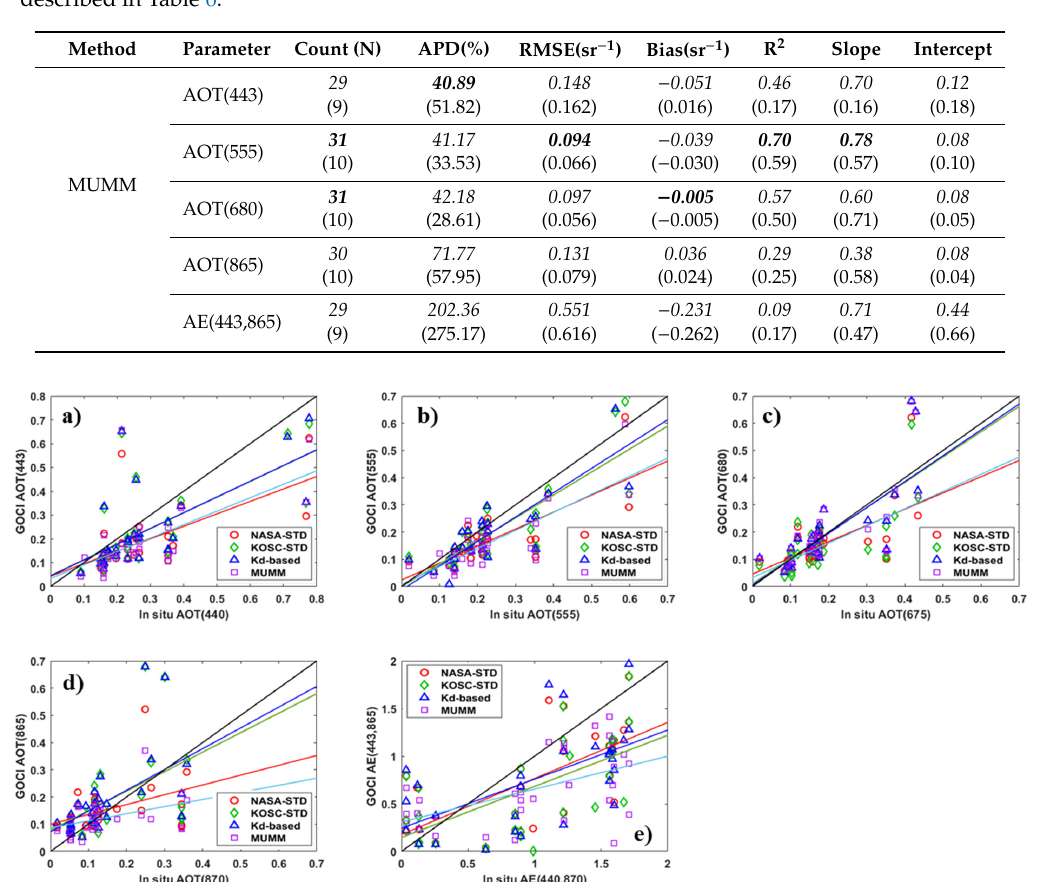
Table 9. Validation statistics for the MUMM method of GOCI-derived AOT(443), AOT(555), AOT(680), AOT(865), and AE(443,865) at 02:16, 03:16, and 04:16 UTC: APD (%), RMSE (sr − 1 ), Bias (sr − 1 ), R 2 (dimensionless), Slope (dimensionless), Intercept (dimensionless). The presentation style is the same as described in Table 6.